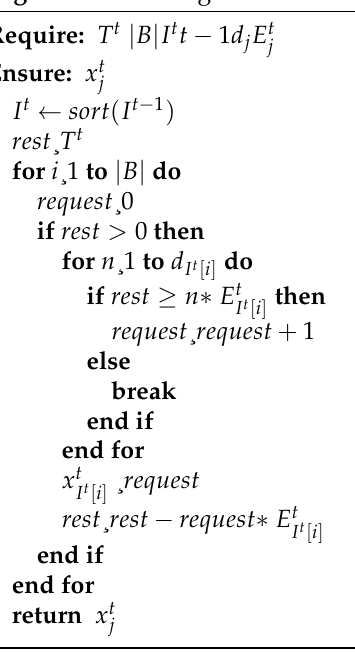
Algorithm 1 The algorithm for requesting power